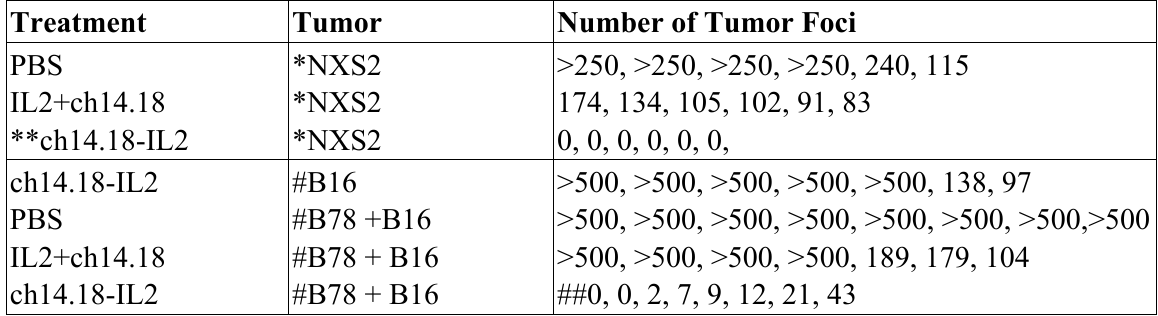
Table 1. Efficacy of ch14.18-IL2 exceeds ch14.18 + IL2.